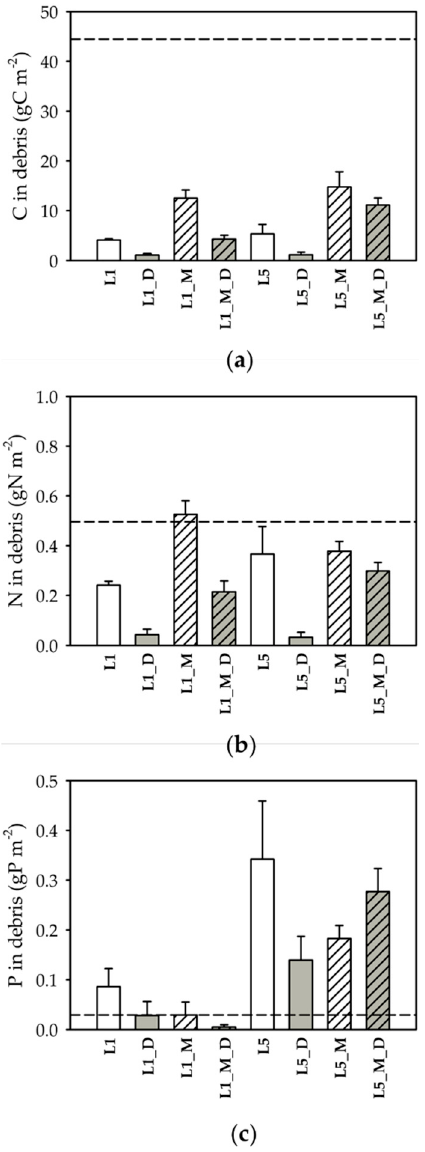
Figure 5. C, N and P content in debris ( a – c ) recovered from each microcosm at the end of the experimental period. Mean ± standard error ( n = 5) are reported. White bars represent the permanently submerged condition, grey bars represent dried conditions and hatched bars represent conditions with macrofauna. The horizontal dash line is the reference value of C, N, P content in leaves at the beginning of the experiment.